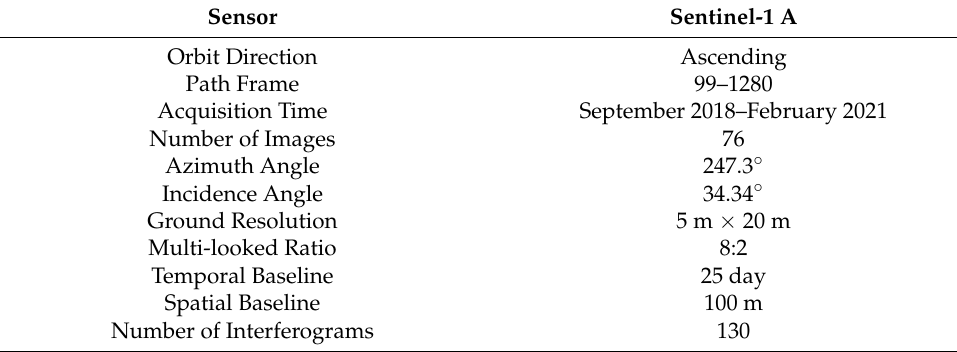
Table 1. Data information and related processing